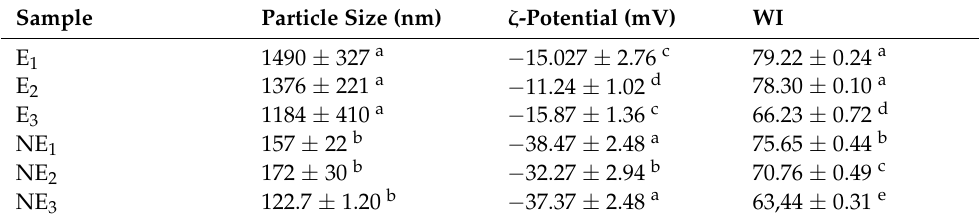
Table 3. Particle size, zeta potential and whiteness index of alginate nanoemulsion-coating solutions.